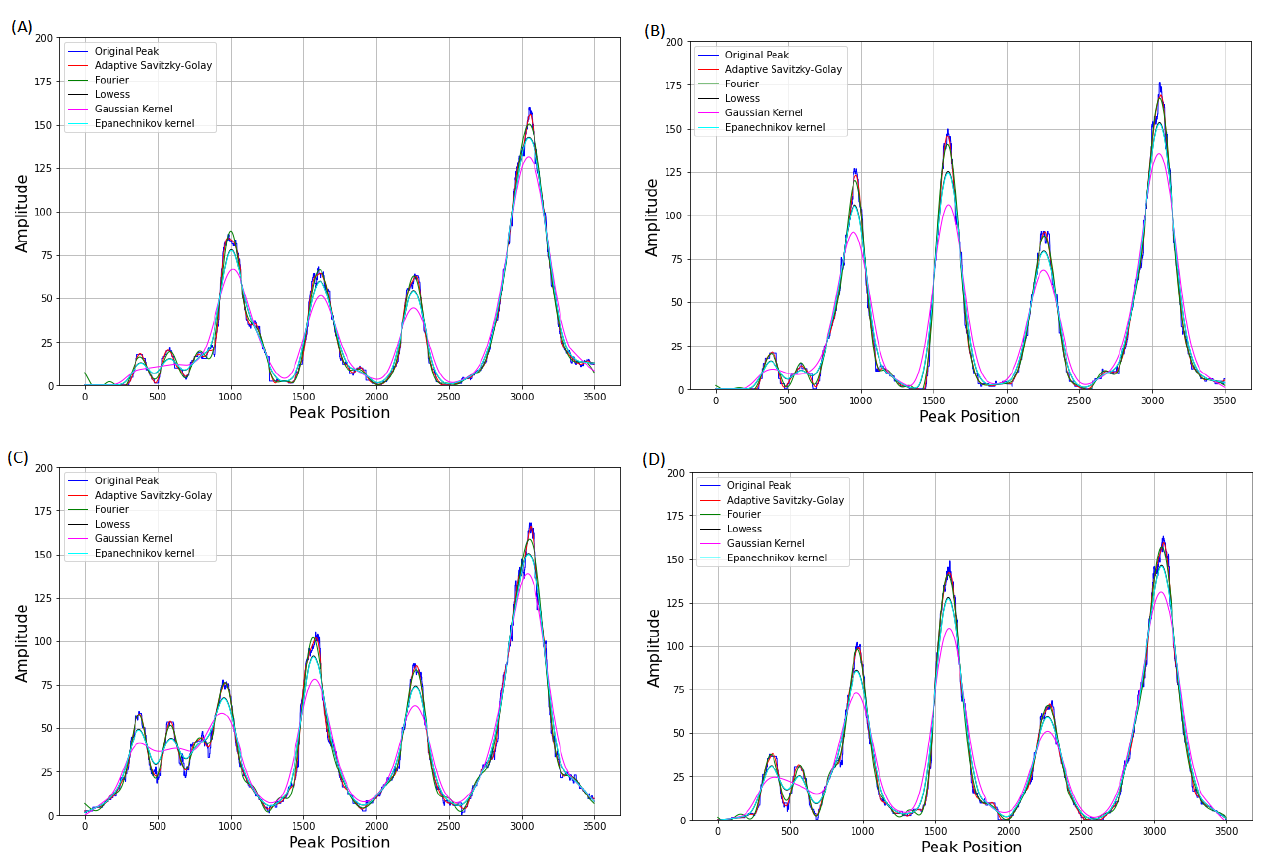
Figure A1. Show comparison of noise suppression of different peaks using our proposed Adaptive Savitzky–Golay filters and other peer filtering methods. ( A ): peak1, m 1 = 51. ( B ): peak2, m 2 = 51; ( C ): peak3, m 3 = 51. ( D ): peak4, m 4 =